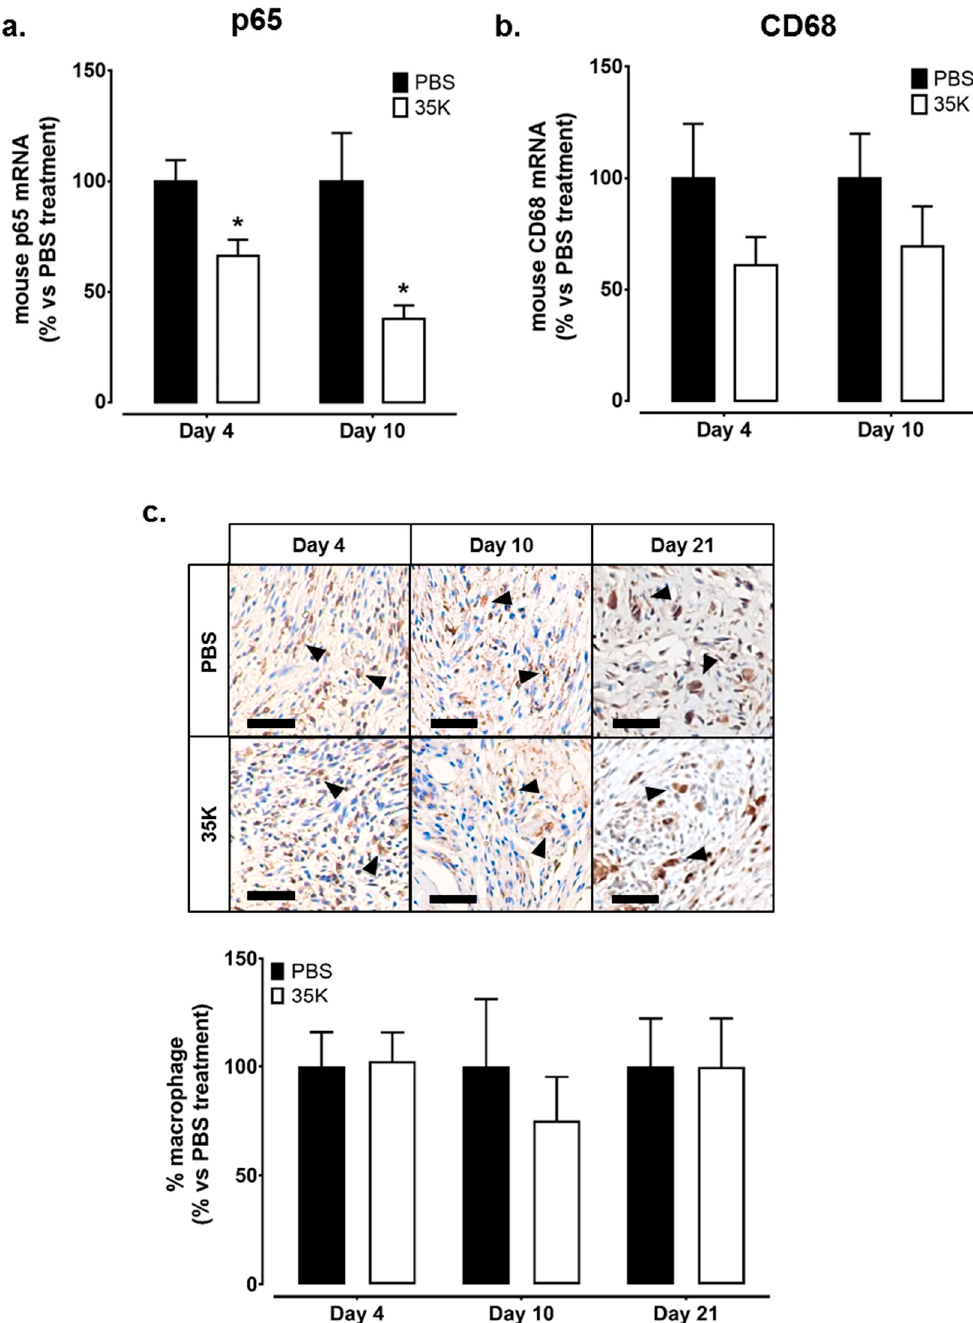
Figure 4. Inhibition of CC-chemokines by 35K reduces inflammation but has no effect on wound macrophage content. Total RNA was isolated from PBS and 35K treated wounds at both the early (Day 4) and late (Day 10) time points ( n = 12/time point). Real-time PCR was used to measure mRNA levels of ( a ) p65, the active subunit of the key inflammatory transcription factor NF- κ B and ( b ) macrophage marker CD68; ( c ) immuno-histochemistry was used to detect the presence of wound macrophages. Photomicrographs represent wound sections stained for CD68+ macrophages (stained brown, noted by black arrows). Three tiled images were taken per wound ( n = 7–12/treatment). Scale bars represent 50 μ m. Data is represented as mean ± SEM. Statistical analysis was performed by an unpaired two-tailed t -test. * p < 0.05 compared to PBS treated wounds.